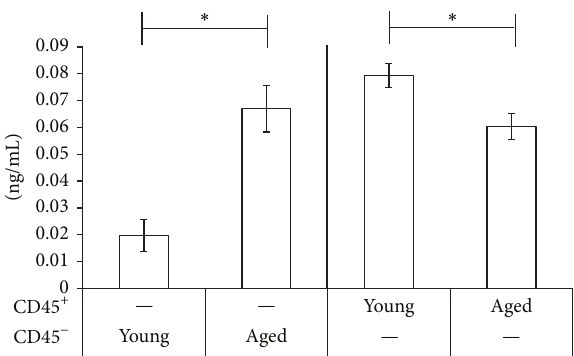
Spleen-derived CD45 − or CD45 + cells from young and aged mice ( 𝑛 = 4 ) were cultured with 10 𝜇 g/mL LPS for 24 h. Supernatants were collected from the cell culture and were analyzed for IL-6 by ELISA. The results are expressed as mean ± SD. The data are the representative of two similar